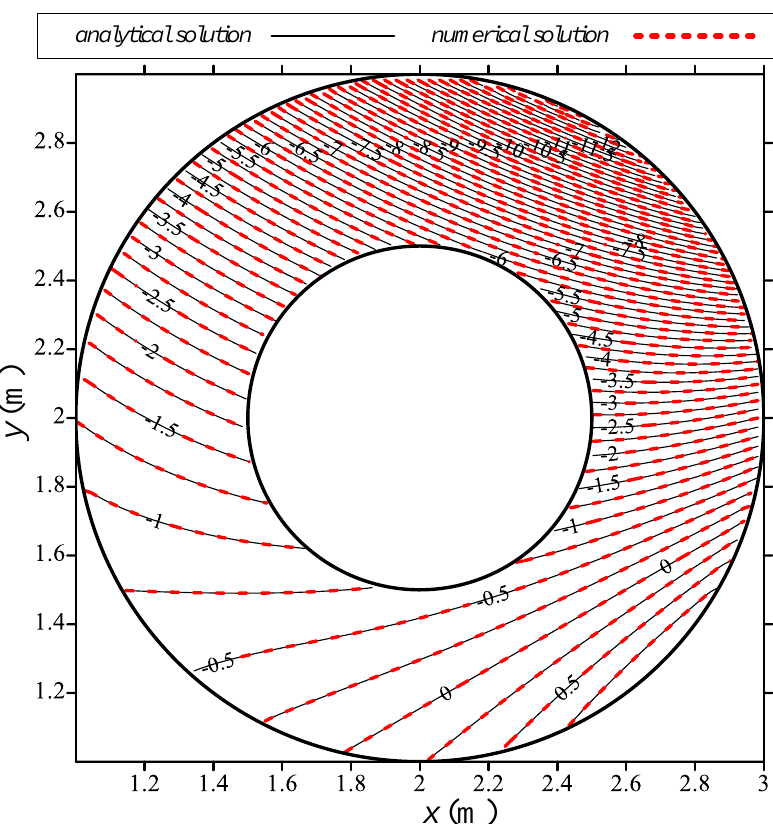
Figure 13. Results comparison with the exact solution.